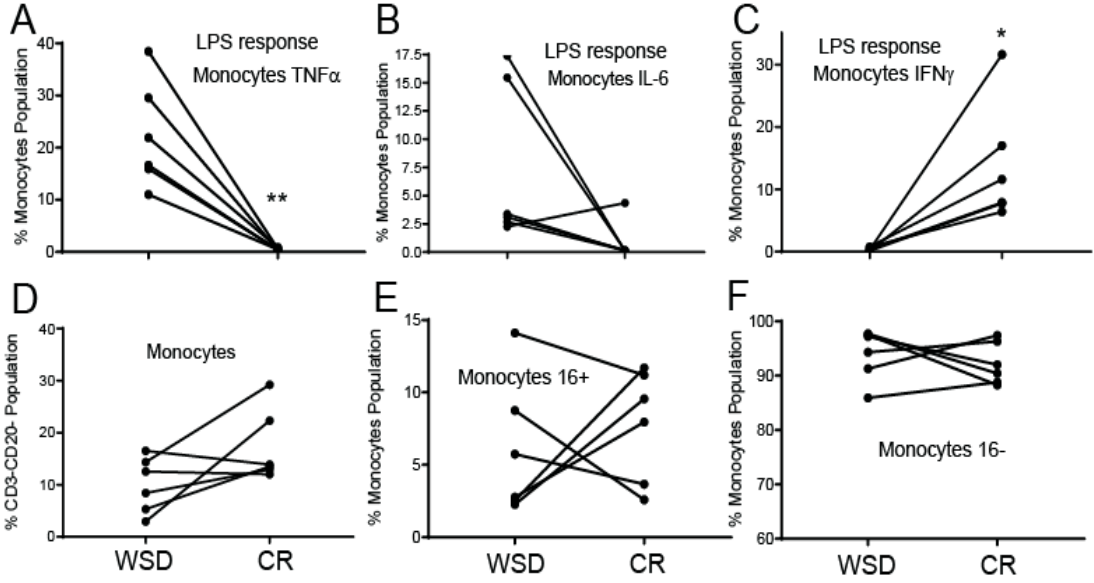
Figure 4. Caloric restriction (CR) suppresses a pro-inflammatory response in circulating monocytes. ( A – C ) Frequency of TNF α , IL-6, and IFN γ producing monocytes following 6 h liposaccharide (LPS) stimulation as measured by intracellular cytokine staining. ( D ) Frequency of monocytes within PBMCs. ( E , F ) Relative frequency of non-classical (CD16 + ) and classical (CD16-) monocytes within the monocyte population; * p < 0.05, ** p < 0.01, paired t -test.